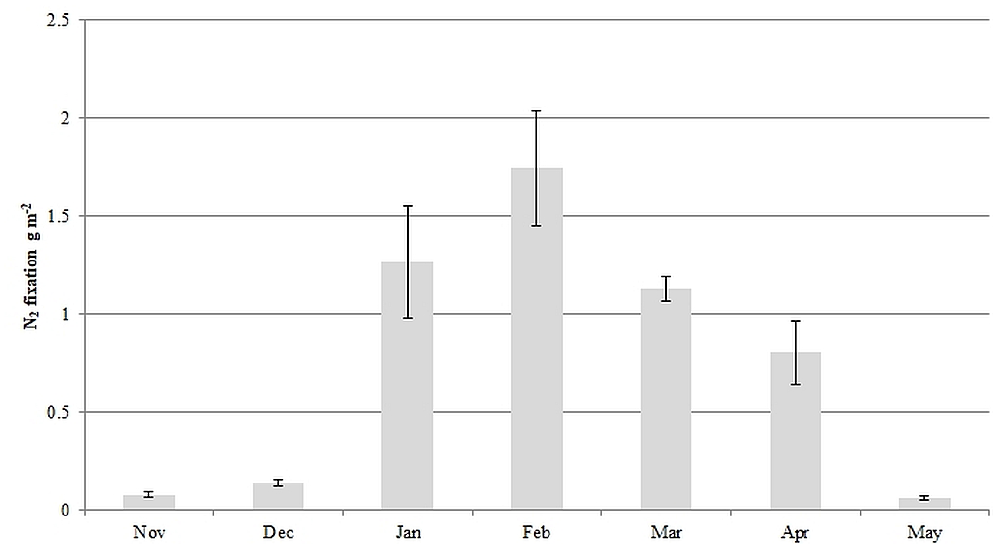
Figure 9. Total cyanobacterial N fixation estimated monthly for 2009–2010 wet season that ranged from 0.08 to 1.74gm − 2 , shown with standard